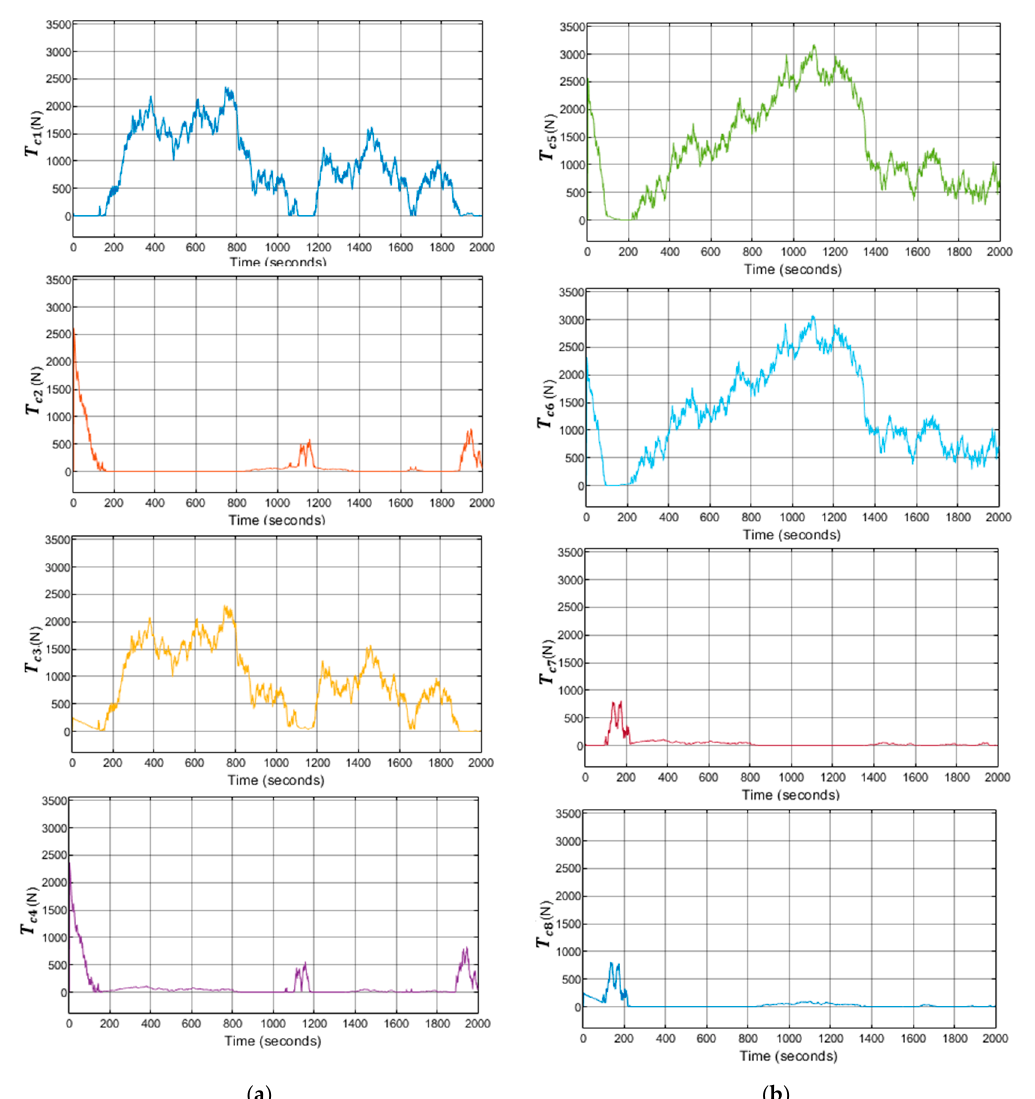
Figure 9. ( a ) System with LQG controller control results with waves, tensions applied in each of the winches 1–4. ( b ) System with LQG controller control results with waves, tensions applied in each of the winches 5–8.